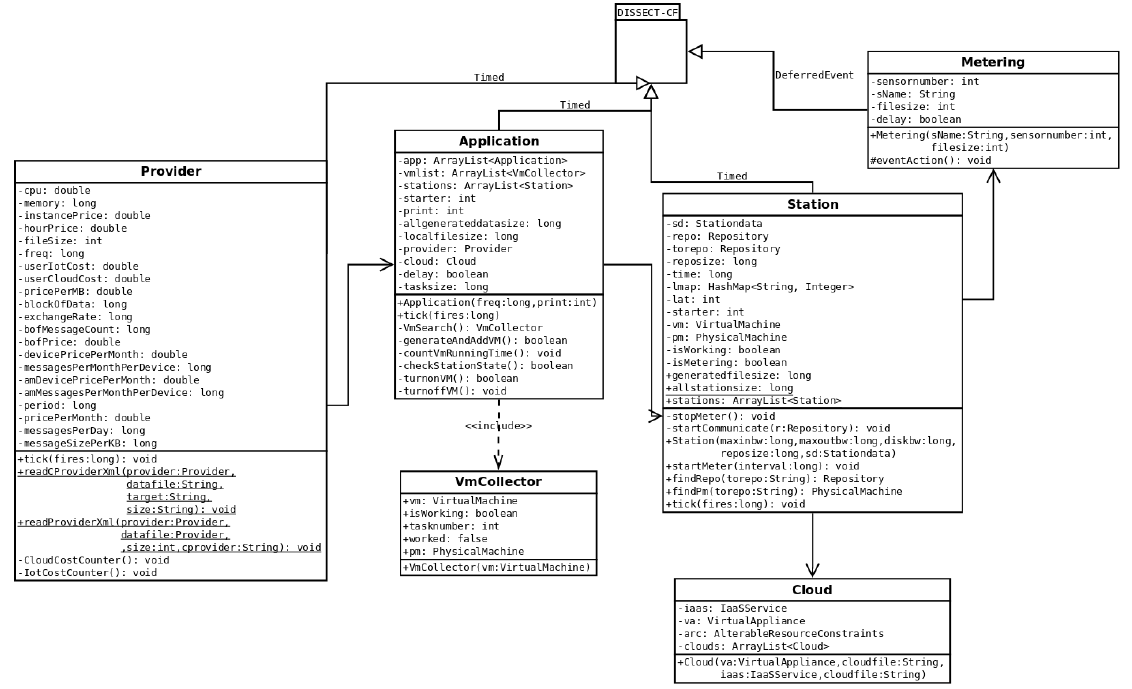
Figure 4. IoT extension classes for